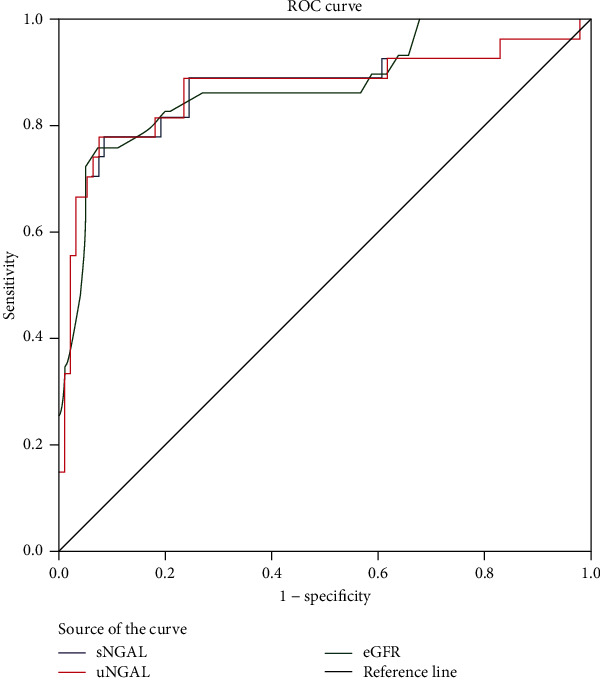
Receiver operating characteristic (ROC) curve of eGFR, serum NGAL, and urine NGAL for prediction of AKI to CKD. eGFR: AUC = 0.857, p < 0.001; cut-off value = 18.5 ml/min/1.73m2, Se = 74.1%, Sp = 92.6%. sNGAL: AUC = 0.868, p < 0.001; cut-off value = 618.72 ng/ml, Se = 77.8%, Spe = 91.5%; uNGAL: AUC = 0.869, p < 0.001; cut-off value = 746.97 ng/ml, Se = 77.8%, Spe = 92.6%.